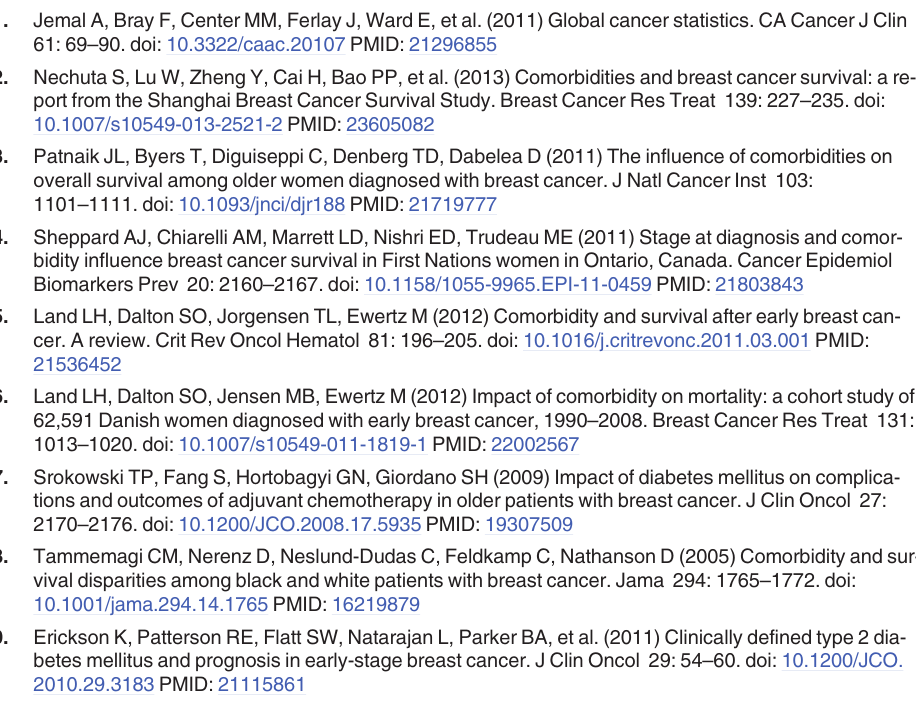
Table C, Association of the diabetes Genetic Risk Score (GRS) with breast cancer outcomes in GWAS data. Table D, Association of the diabetes Genetic Risk Score (GRS) with breast cancer outcomes from a sensitivity analysis in which 129 patients with extreme follow-up time (short- est 1% and longest 1%) were